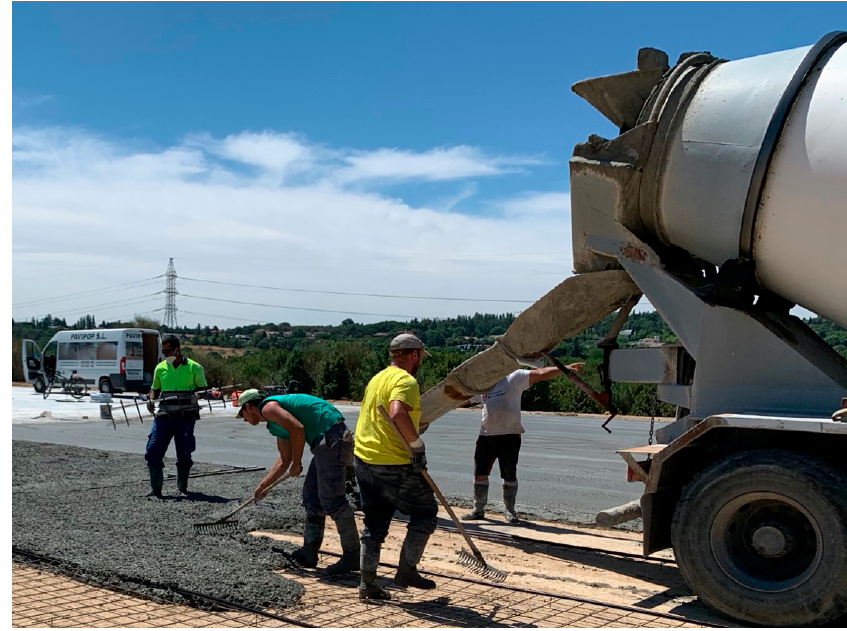
Figure 2. Workers spreading concrete on an open-air screed without keeping safety distance (author’s photograph).